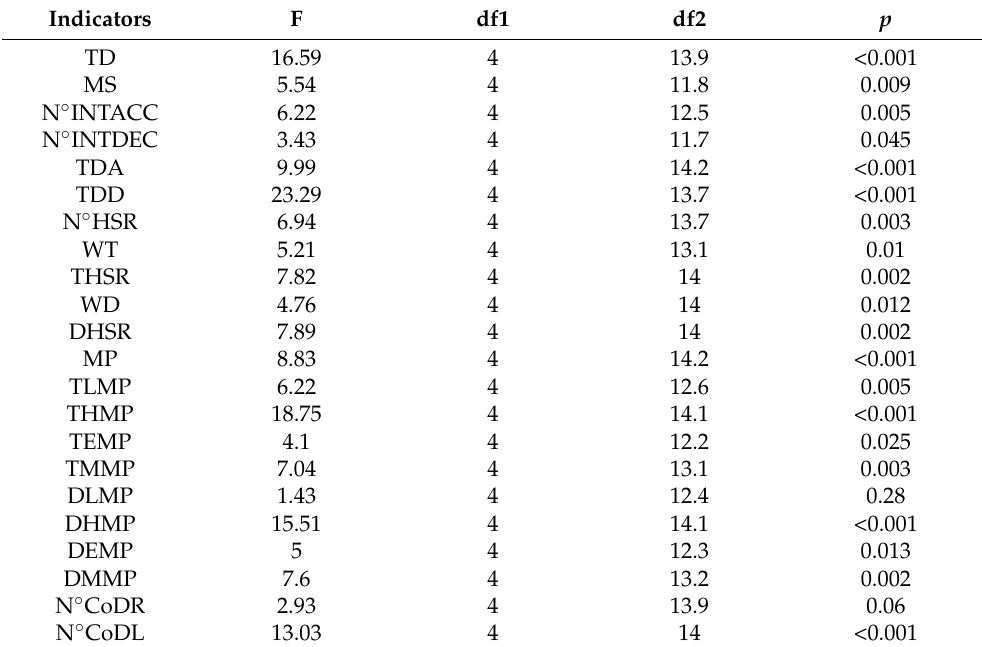
Table 6. One-way ANOVA test